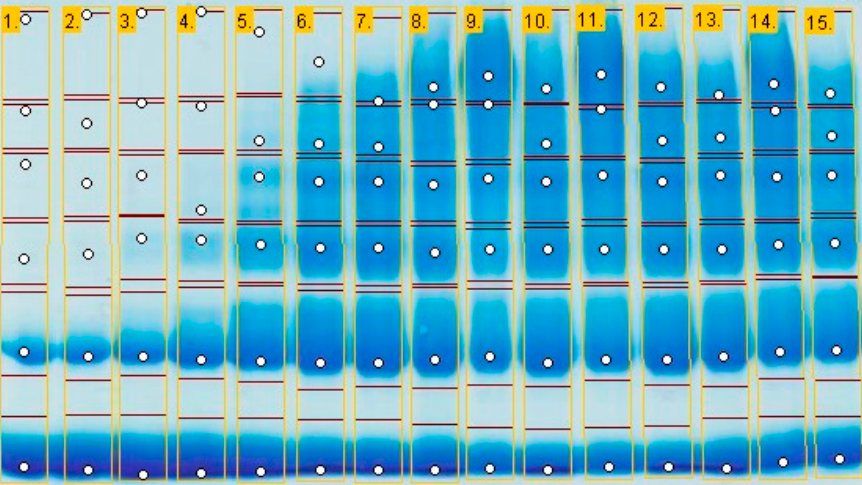
Figure 4. A 12% SDS-PAGE of 1.5 mM haemoglobin polymerization with varying concentrations of GA: